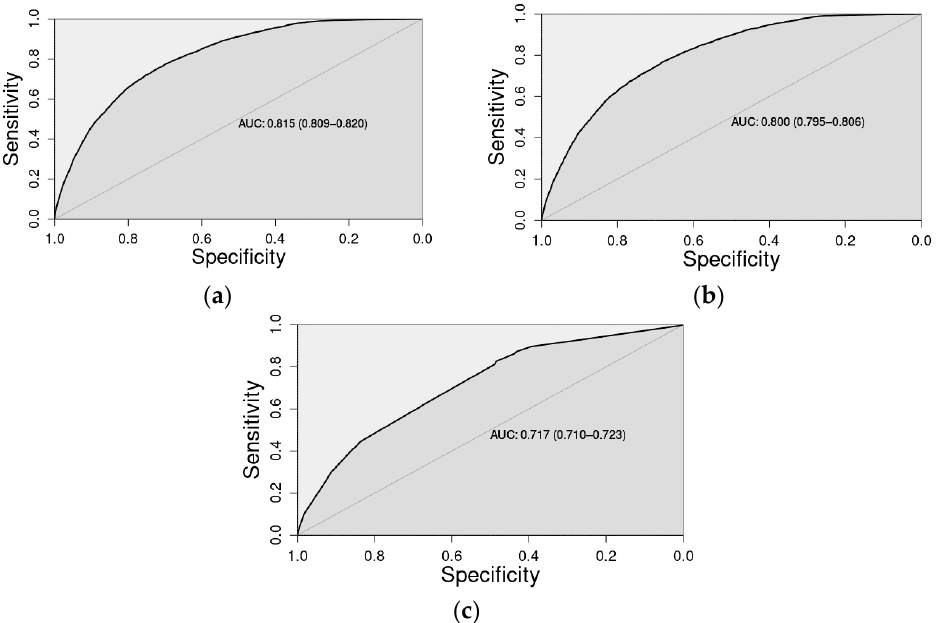
Figure 1. Receiver operating characteristic curves where sensitivity ( y -axis) is plotted against specificity ( x -axis), and the area under the curve (AUC) values (corresponding 95% confidence intervals) are provided for the following multivariate logistic regression models: ( a ) patient-level and competing resources information; ( b ) patient-level characteristics only; and ( c ) competing resources only.